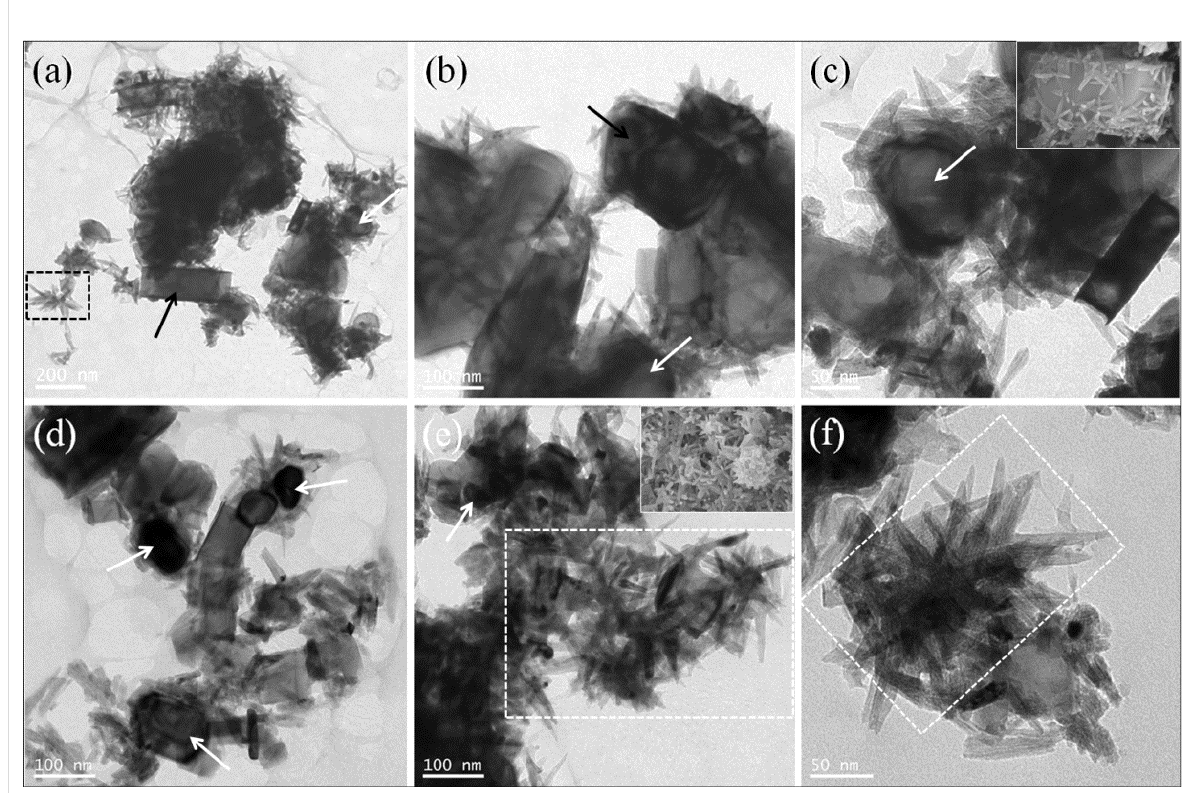
Figure 5: Typical TEM and FSEM images of the as-synthesized TiB 2 /(TiB 2 –TiN) samples with different thickness of the infiltration and erosion layers. Scale bars: (a) 200 nm, (b) 100 nm, (c) 50 nm, (d) 100 nm, (e) 100 nm and (f) 50 nm.